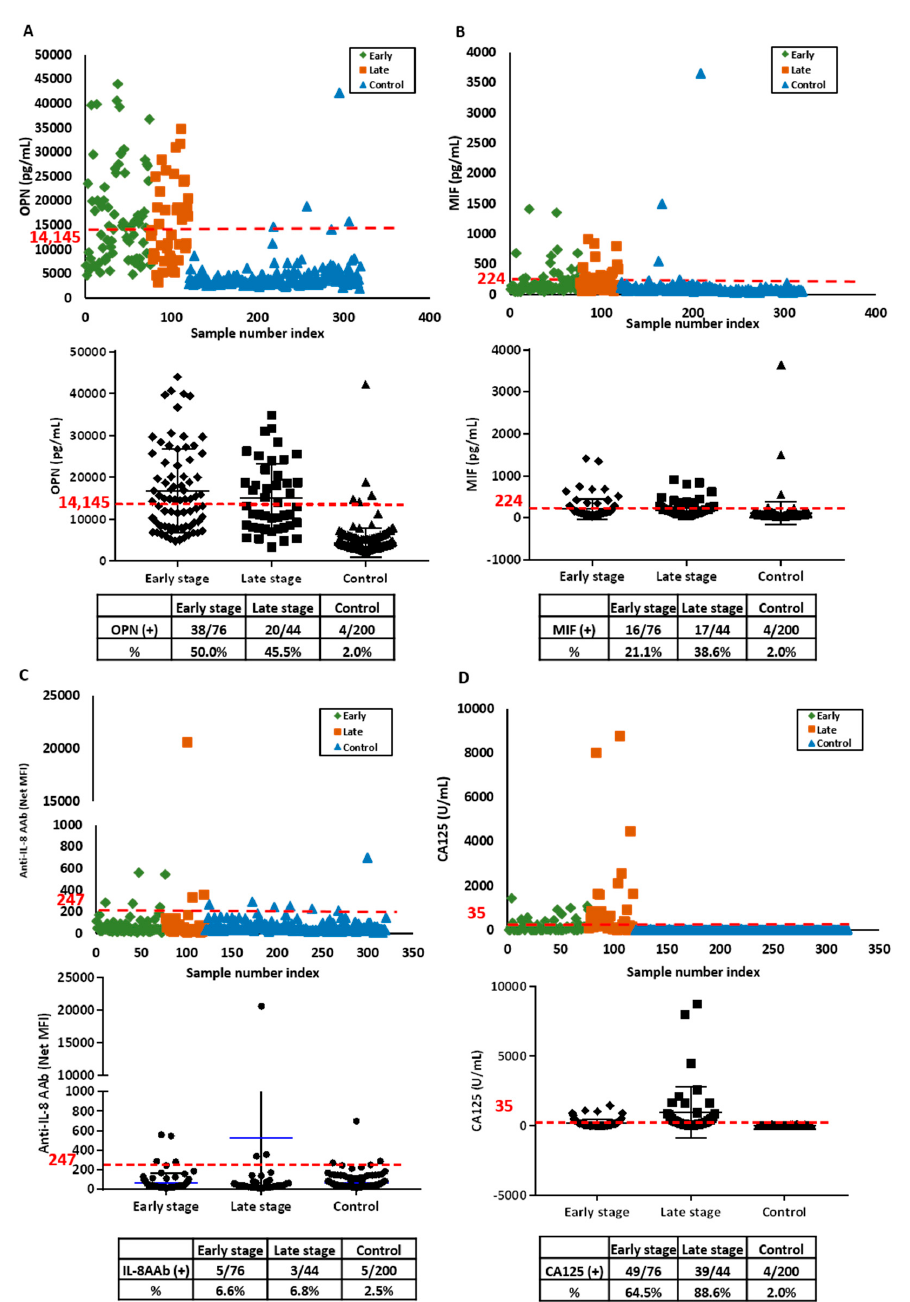
Figure 1. Serum levels of osteopontin (OPN), macrophage inhibitory factor (MIF) anti-IL-8 autoantibody and CA125 are elevated in the discovery set from ovarian cancer patients and healthy controls. ( A ) OPN antigen; ( B ) MIF antigen; ( C ) anti-IL-8 autoantibodies (AAb) and ( D ) CA125 antigen. In the upper panels, each symbol represents the average of duplicate serum samples from individual early stage ovarian cancer cases (green), late stage ovarian cancer cases (red) or controls (blue). The middle panels contain a scatter plot where the blue line represents the median value in early and late stage case and control groups, respectively. The red dashed lines in each plot represent the cut-o ff value at 98% specificity for OPN, MIF and anti-IL-8 AAb, and cut-o ff value of 35 U / mL for CA125. The lower panel is a table displaying the sensitivity for early and late stage ovarian cancer cases and controls near 98%